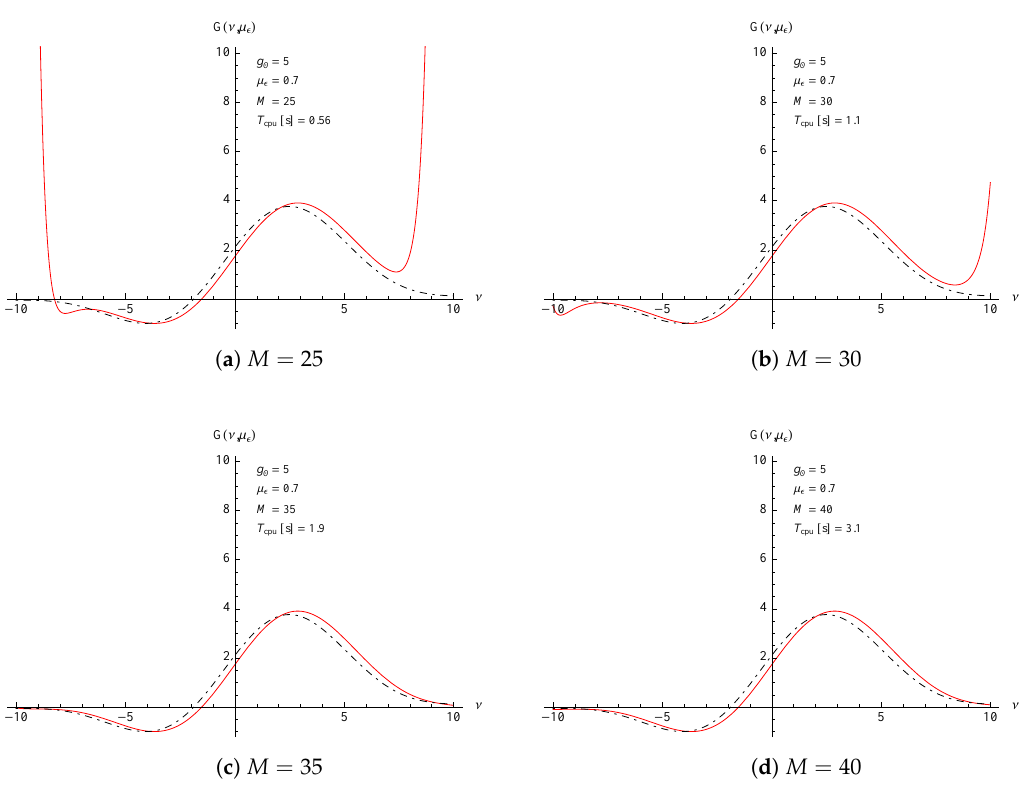
Figure 3. Comparison with analiytical expression (black dash-dotted line) in the case of higher broadening effects ( µ ε = 0.7) for different truncation levels (M) and g 0 = 5. The CPU time used refers to an Intel I7 3 GHz